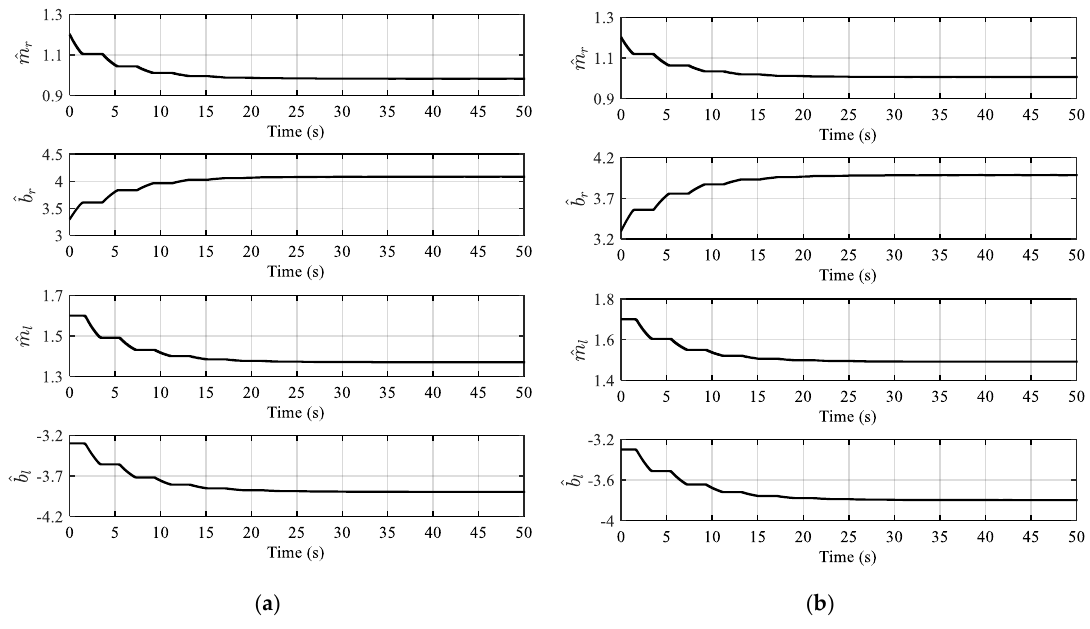
Figure 8. The convergence results of dead-zone parameters: ( a ) Dead-zone parameter estimation curve of hydraulic actuator 1; ( b ) dead-zone parameter estimation curve of hydraulic actuator 2.